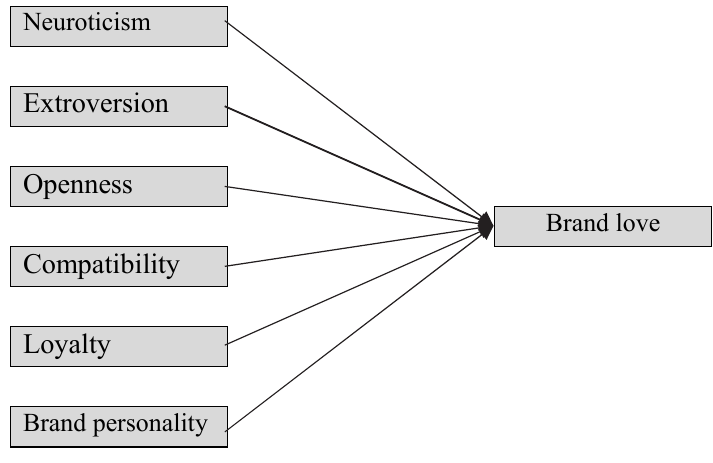
Fig. 2. The structure of different brand personality factors on brand love